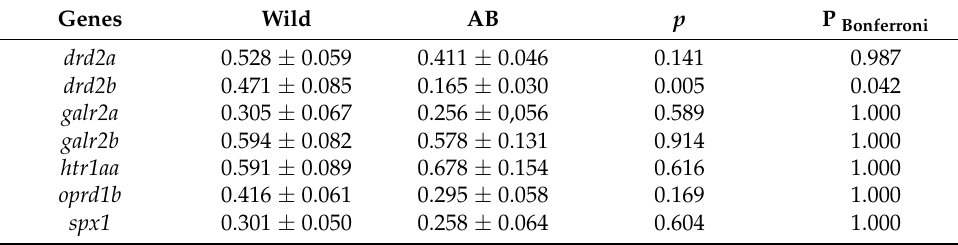
Table 4. Brain gene expression in 30 dpf zebrafish larvae of the strains AB and wild (see Materials and Methods). Values indicate relative mRNA levels ± SEM.